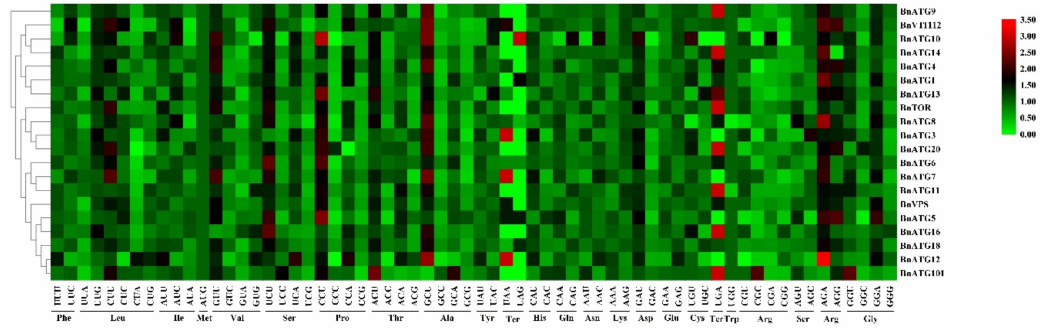
Figure 11. Heat map of relative synonymous codon usage analysis (RSCU) values of BnATGs. The color boxes indicate RSCU values, the lowest (green), and the highest (red) usage of codons. The heatmap was generated using